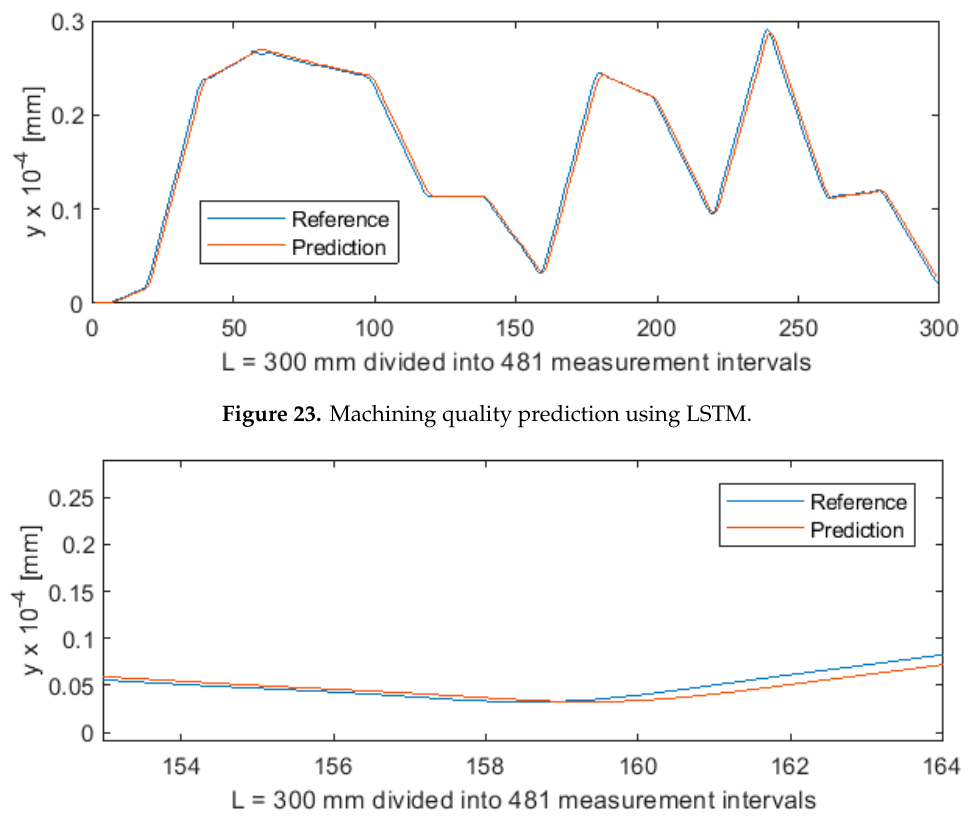
Figure 24. Machining quality prediction using LSTM—detail of the process for L = 154 ÷ 165 mm in Figure 22.